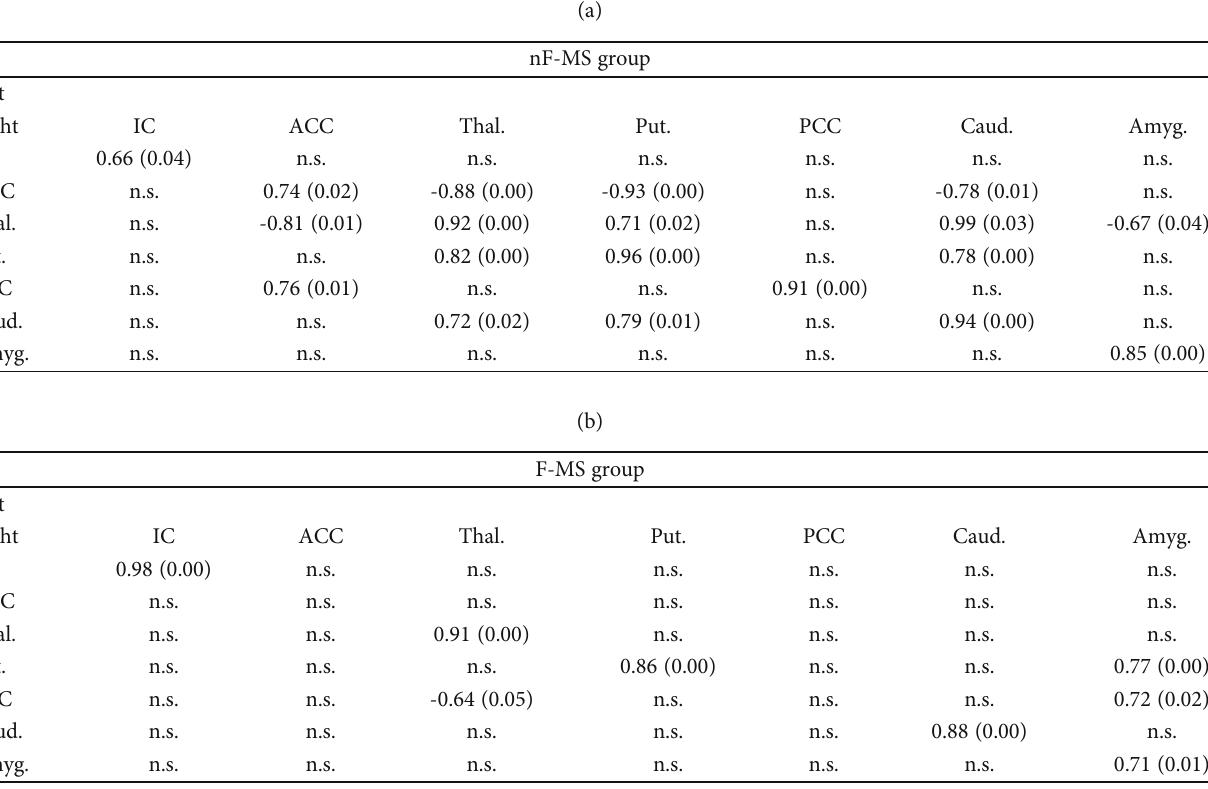
Table 3: Bivariate transhemispheric correlations between the di ff erent VOIs from the